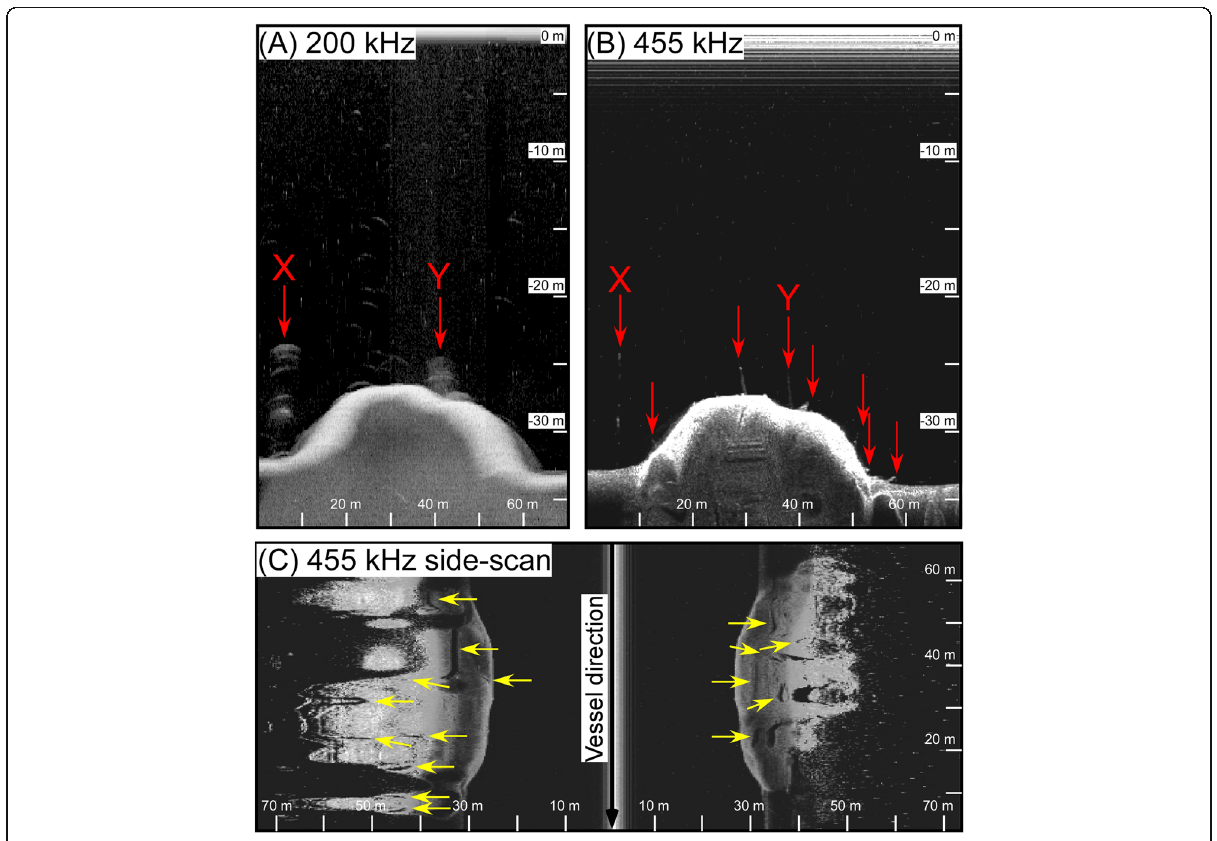
Fig. 1 Sonar images obtained by a a 200 kHz acoustic source (P391 transducer, Airmar), b 455 kHz acoustic source (StructureScan® HD, Lowrance), and c 455 kHz side-scan (StructureScan® HD, Lowrance) for the same track. The red arrows indicate the submerged trees; X and Y on a and b are the same objects. Brighter images suggest stronger acoustic reflection. c Side-scan image shows the areal distribution of acoustic reflections on the lake floor; prominent materials on the floor are bright and their shadows are dark. Thus, the shape of materials on the floor is identifiable; for example, submerged trees (yellow arrows) have long